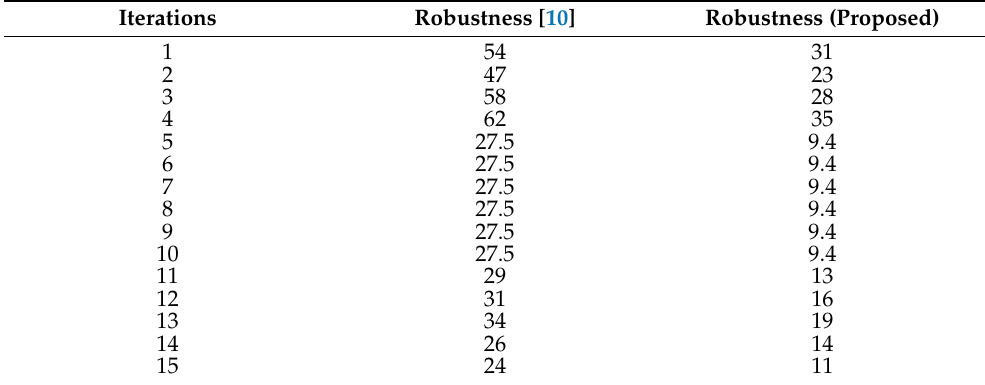
Table 8. Strength of probabilistic algorithm.